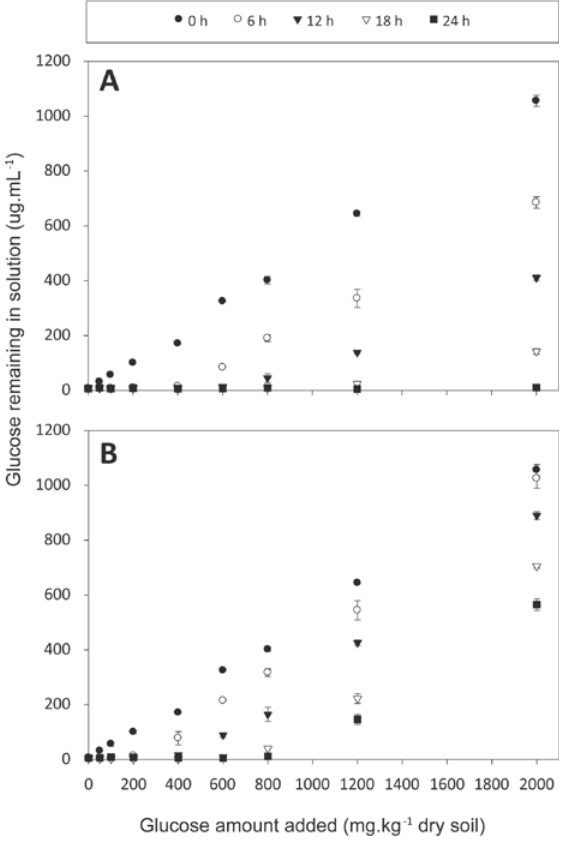
Fig. 2 - Glucose remaining in soil solution extracted with NaCl (0.5%) under incubation conditions for 0, 6, 12, 18 and 24h at room temperature. Pattern the glucose consumption in NT ( A ) and CT ( B ). The bars show the confidence intervals to 95% probability